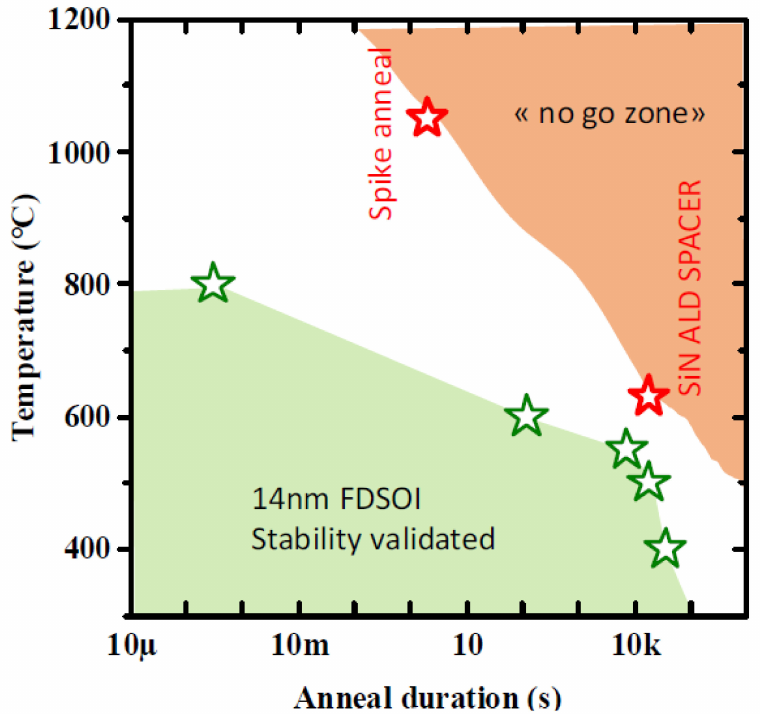
Figure 1. Acceptable thermal budget to preserve the performance of bottom-tier devices. Reprinted with permission from Ref. [3]. 2017,